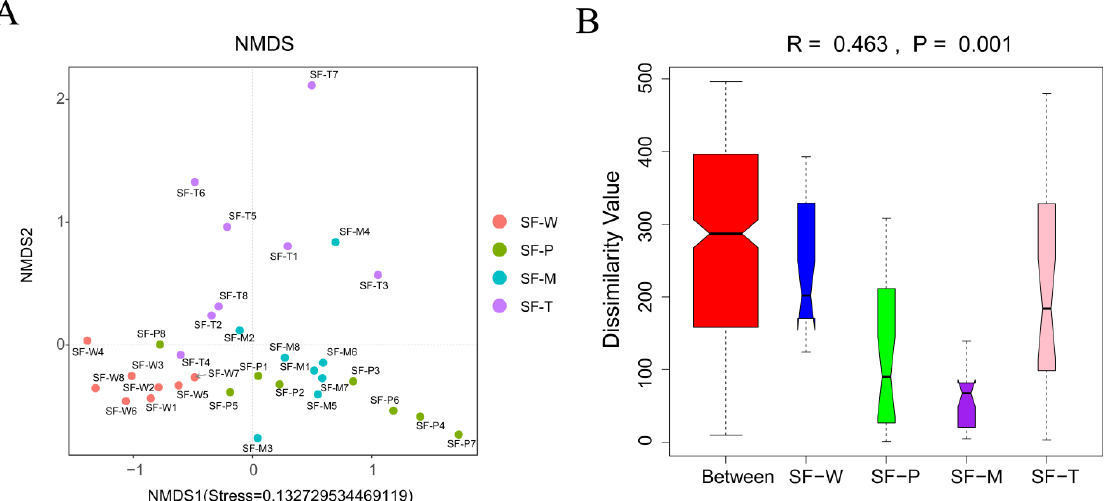
Figure 4. Beta diversity analysis of gut flora. ( A ) NMDS analysis: The points in the figure represent the samples, and the distance between the points indicates the degree of difference; the stress <0.2 indicates that NMDS analysis had certain reliability. ( B ) Anosim analysis: The R value was (−1,1). R > 0 indicates that the difference among groups is greater than that within groups, and R < 0 indicates that the difference within groups is greater than that among groups. The reliability of statistical analysis is expressed by p -value, and p < 0.05 indicates statistical significance.